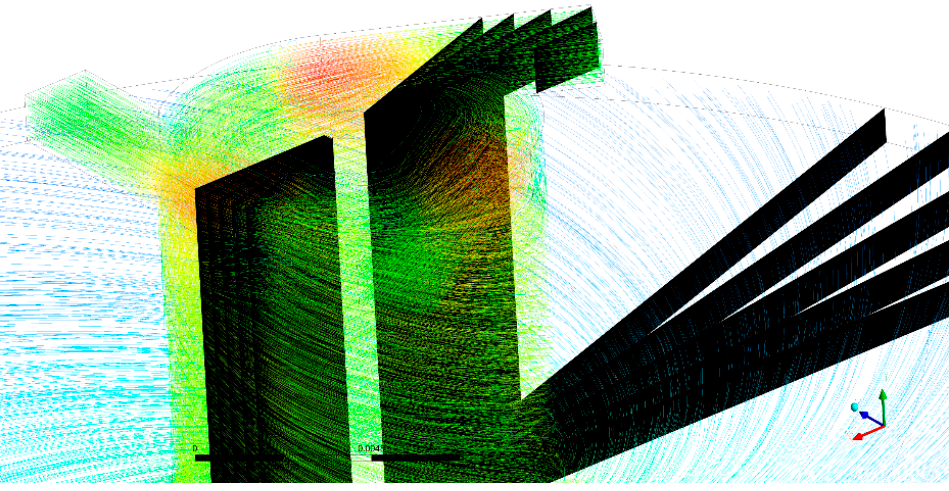
Figure 11. Cut planes SVT.